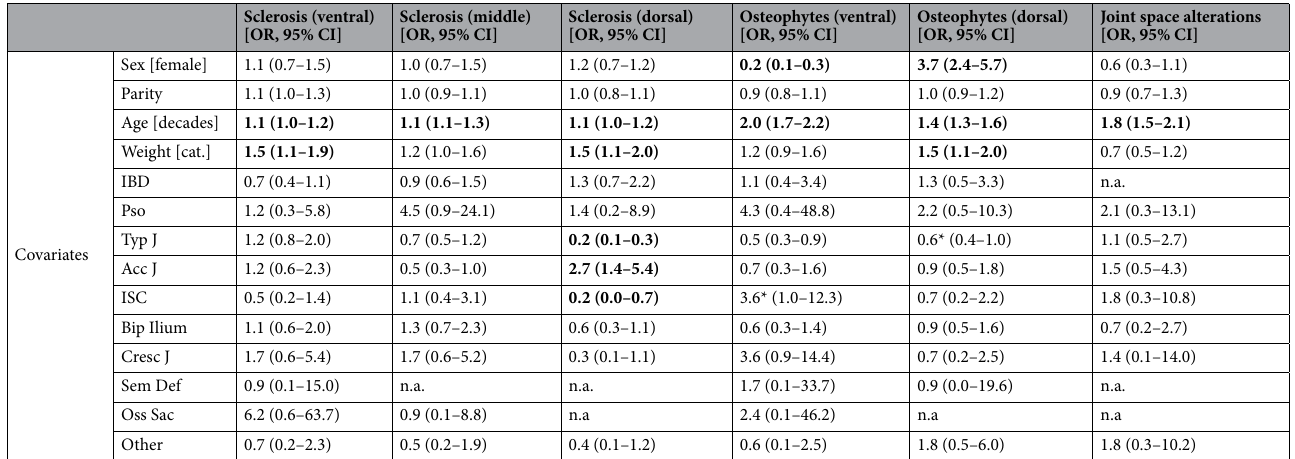
Table 4. Regression analysis. Results of binary logistic regression analyses. Significant ORs with 95% CIs excluding 1.0 are written in bold. OR odds ratio, CI confidence interval, IBD inflammatory bowel disease, Pso cutaneous psoriasis, Typ J typical joint form, Acc J accessory joint, ISC iliosacral complex, Bip Ilium bipartite ilium, Cresc J crescent-shaped ilium, S em Def semicircular defects, Oss Sac sacral ossification centers, other other joint form.